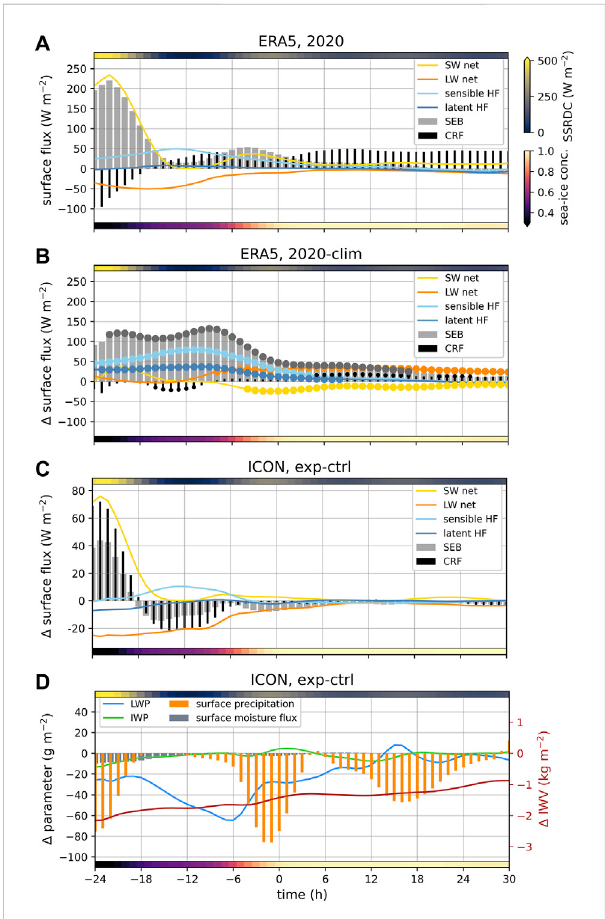
FIGURE 7 (A – C) Time series of the SEB and its components (net short- and longwave SW and LW, sensible and latent heat fl uxes HF), as well as CRF along trajectories. At the top of each graph, ERA5-based surface shortwave downward radiation under clear-sky conditions (SSRDC)isdepicted.Atthebottomofeachgraph,ERA5-basedsea-ice concentration is shown. Time is relative to 19 April, 12 UTC. (A) ERA5 reanalysis, 2020 event (B) Difference of 2020 WAI minus 1979 – 2020 climatology, based on ERA5. Dots indicate timesteps where surface fl uxes exceed one climatological standard deviation. (C) Differences EXP-CTRL based on ICON-LAM simulations. (D) As in (C) but for LWP and IWP, IWV, surface precipitation and surface moisture fl